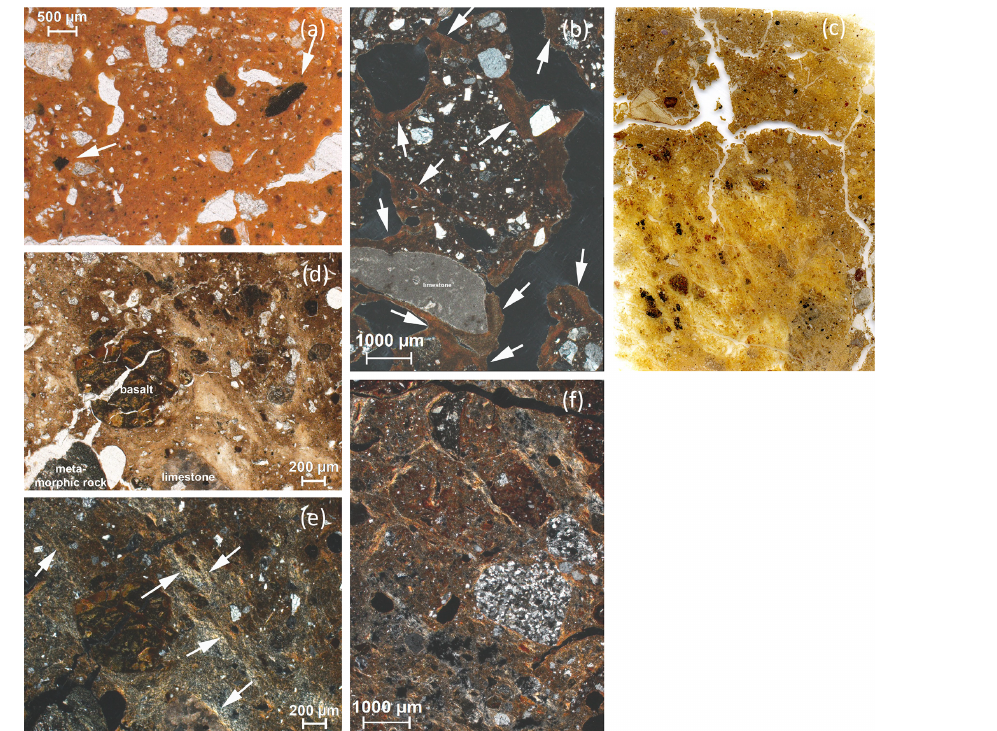
Figure 8. Micromorphological analysis of the buried plow horizon (2Apb). (a) White arrows point at fragments of charcoals ( < 500µm) – ABR SA2 183–193cm: OIL, ppl; (b) very dusty clay coating (white arrows) with incorporated coarse material – ABR SA2 183–193cm: xpl; (c) scan of the thin section 6 × 9cm – ABR SA2 180–190cm; (d) compacted (low porosity) rounded to subrounded peds and rock fragments; some channels and one partially accommodating plane are present. Some peds are surrounded by a granostriated b -fabric – ABR SA2 180–190cm; xpl; (e, f) about 45 ◦ inclined bands with alternating coarse and fine material; mosaic to striated b -fabric (white arrows) – ABR SA2 180–190cm; (e) ppl; (f)